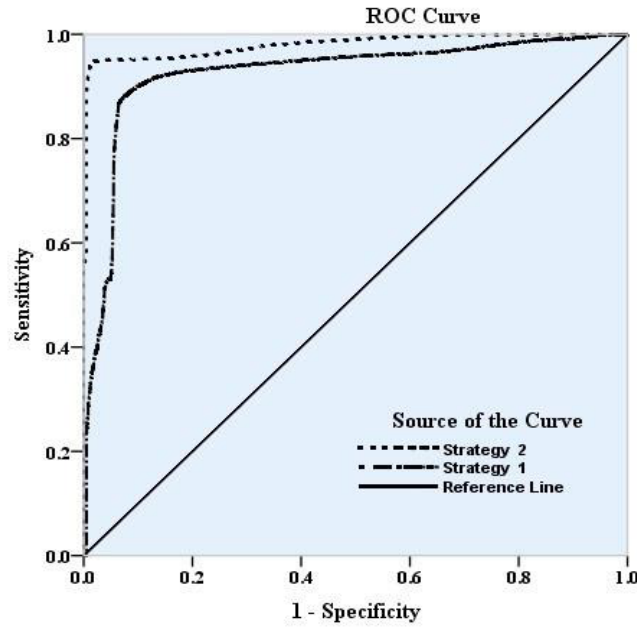
Figure 10. The ROC curves for